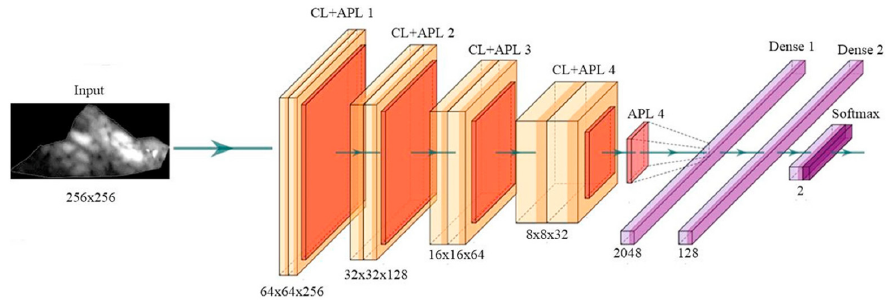
Figure 16. The general structure of CNN architecture (courtesy of AtheroPoint™, Roseville, CA, USA) [206,208].